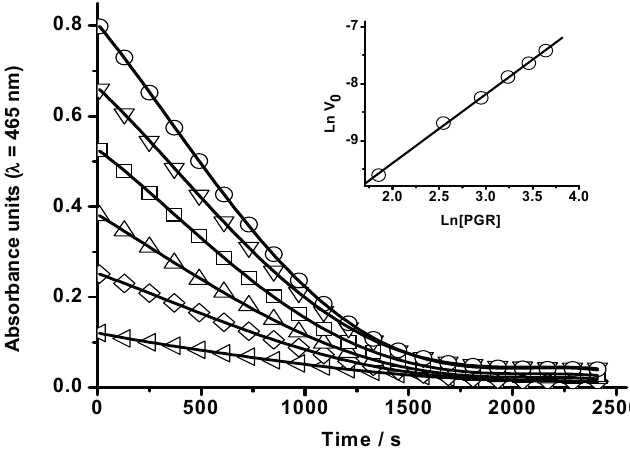
Figure 2. Influence of the PGR concentration on its HONO-mediated bleaching. [PGR] = 6 μ M (  ), 13 μ M ( ◊ ), 20 µM ( Δ ), 26 μ M ( □ ), 32 μ M (  ), and 38 μ M ( ○ ).